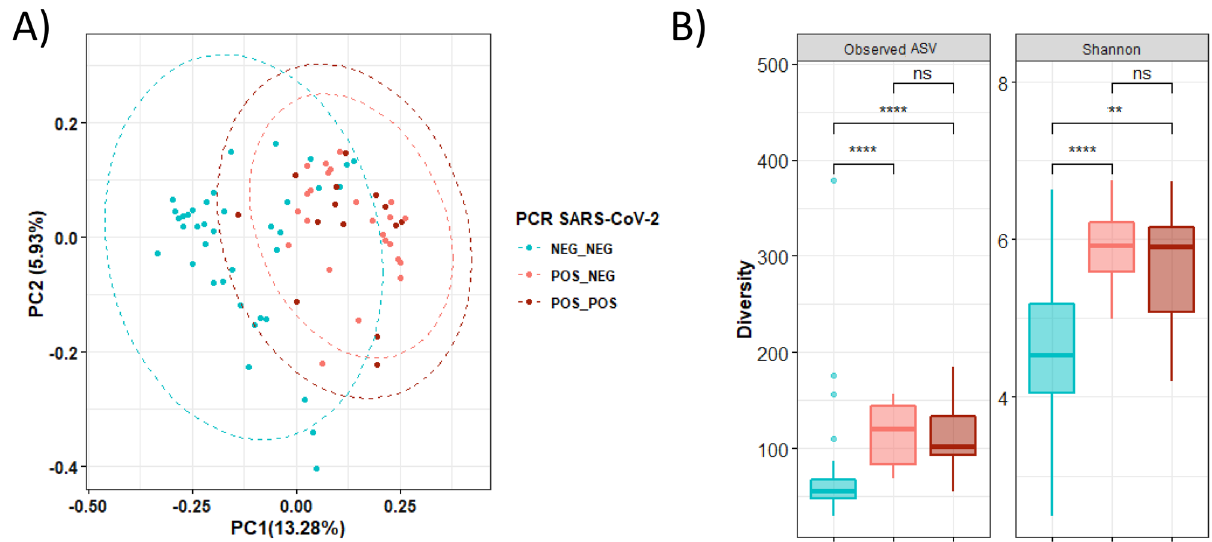
Figure 2. Similar nasopharyngeal microbiota in SARS-CoV-2-infected pregnant women with an active infection (positive RT–PCR and antibodies) versus a past infection (negative RT–PCR but positive antibodies). ( A ) Principal coordinates analysis (PCoA) ordination plot based on unweighted UniFrac distances according to the results of both serological and RT–PCR tests for SARS-CoV-2 infection (ADONIS F = 1.36 , p = 0.001). Each point corresponds to a sample. ( B ) Boxplots showing the differences in the alpha diversity measured as observed ASV and Shannon indexes according to the results of both serological and RT–PCR tests for SARS- CoV-2 infection. POS_POS: Pregnant women with SARS-CoV-2 positive result for serological test and for nasopharyngeal RT–PCR (active infection); POS_NEG: SARS-CoV-2 positive result for serological test but negative nasopharyngeal RT–PCR (past infection); NEG-NEG: Noninfected pregnant women with SARS- CoV-2 negative serological and nasopharyngeal RT–PCR results. Statistical analysis of the differences between groups was calculated using the Kruskal–Wallis test with FDR correction for multiple comparisons. * p < 0.05; ** p < 0.01; *** p < 0.001; **** p <